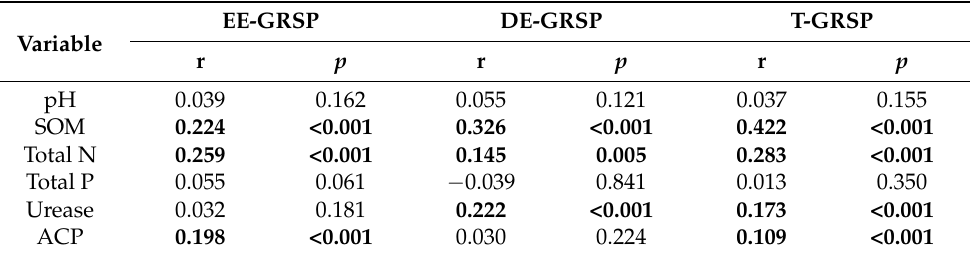
Figure 5. Relationship among GRSP and soil chemical properties of the sampling sites. EE-GRSP, DE-GRSP, T-GRSP, SOM, and ACP represent easily extractable glomalin-related soil protein, difficult-to-extract GRSP, total GRSP, soil organic matter, and acid phosphatase, respectively. * p < 0.05. Table 1. The correlation (r) and significance ( p ) values of Mantel test between glomalin–related soil protein and soil properties.